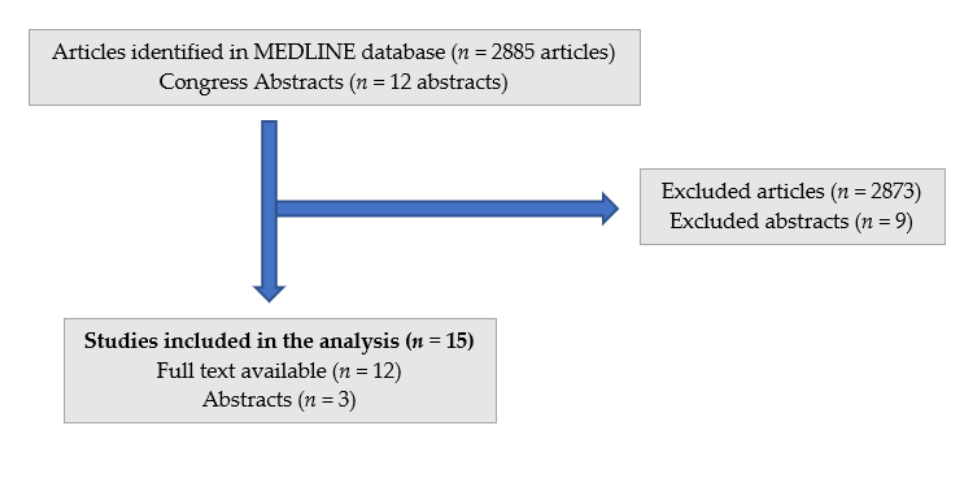
Figure 1. Flow chart of study selection.